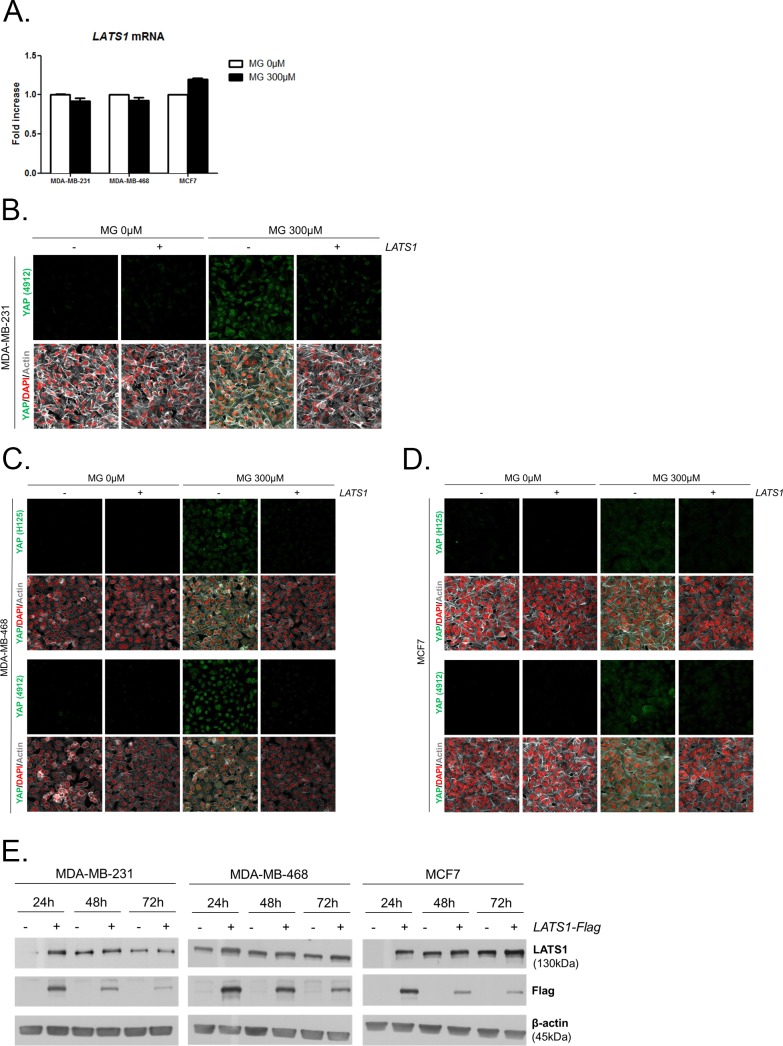
MG leads to YAP cellular accumulation through LATS1 expression decrease.(A) MG treatment from low to high density did not affect LATS1 mRNA levels as assessed by qRT-PCR in the indicated cell lines. Data were analyzed using unpaired student’s t test and shown as the mean values ± SEM of three independent experiments. (B) YAP immunofluorescence (Cell Signaling antibody, 4912) in MDA-MB-231 cells transiently transfected with LATS1 (+) or empty vector (-) and then treated with MG (300 µM) until confluence. Magnification 630x. (C and D) YAP immunofluorescence detection (Santa Cruz antibody, H125 and Cell Signaling antibody, 4912) in MDA-MB-468 and MCF7 cells, respectively, transiently transfected with LATS1 (+) or empty vector (-) and then treated with MG (300 µM) until confluence. Magnification 630x. (E) Validation of LATS1 overexpression in breast cancer cells by western blot using LATS1 and Flag antibodies. β-actin is used for normalization. All data are representative of three independent experiments.